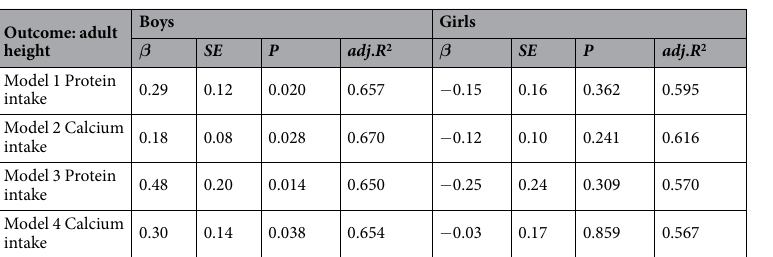
Table 2. Multivariable adjusted regression analysis of adult height as outcome variable and dietary protein (per 10 g increase) and calcium (per 100 mg increase) as predictors in adolescent boys and girls with plant-based diet. Model 1 used full data from 1989 to 2011, adjusted for baseline age, height, and weight, adult age and weight, year of birth, paternal and maternal height, urbanization index, latitude, DNR, average dietary intake of total energy, average energy adjusted dietary intakes of vitamin A, iron, and zinc during adolescence, stratum, and household income level. Model 2 adjusted as Model 1 and additionally adjusted for protein intake. Model 3 only used data since 1997, adjusted as model 1, and additionally adjusted for physical exercises level. Model 4 adjusted as Model 3 and additionally adjusted for protein intake. BMI: body mass index; DNR: annual average direct normal radiation; SE: standard error for β